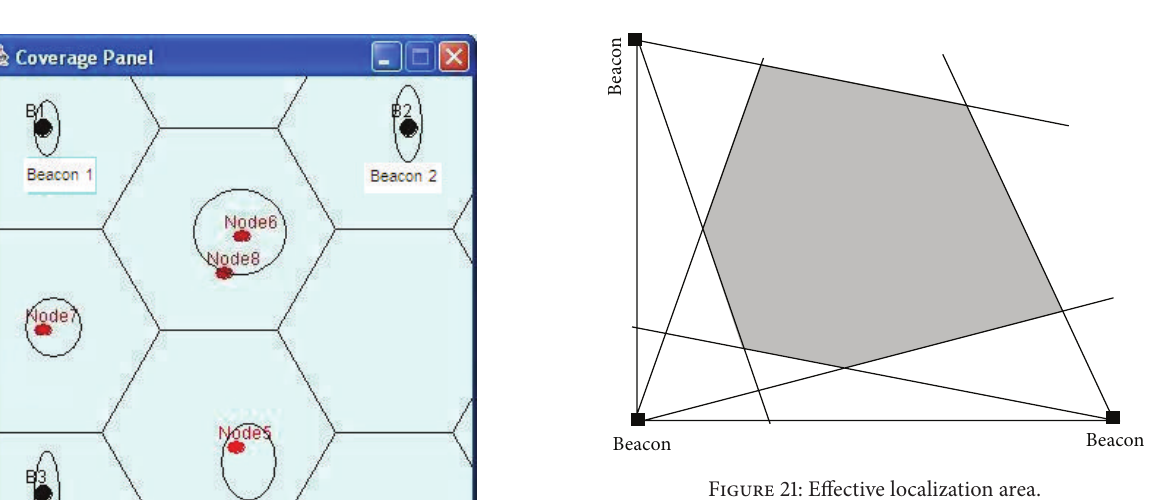
Figure 21: Effective localization